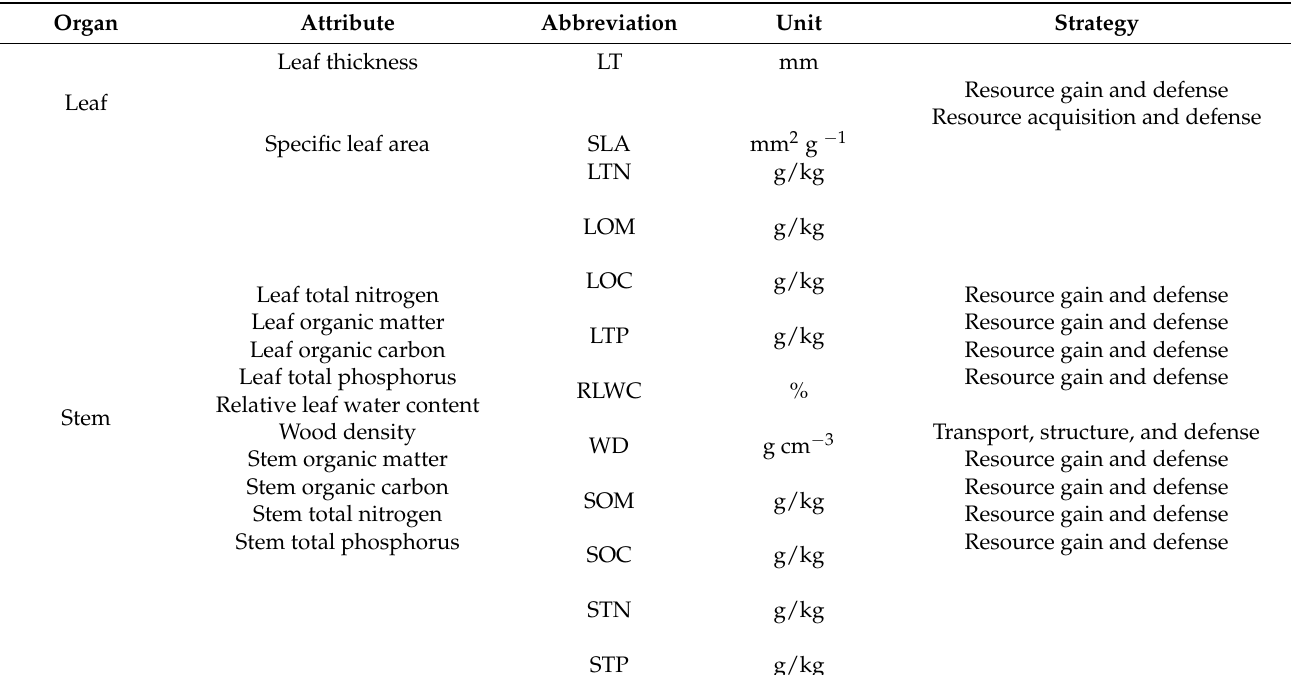
Table 1. A list of 12 functional properties and their ecological